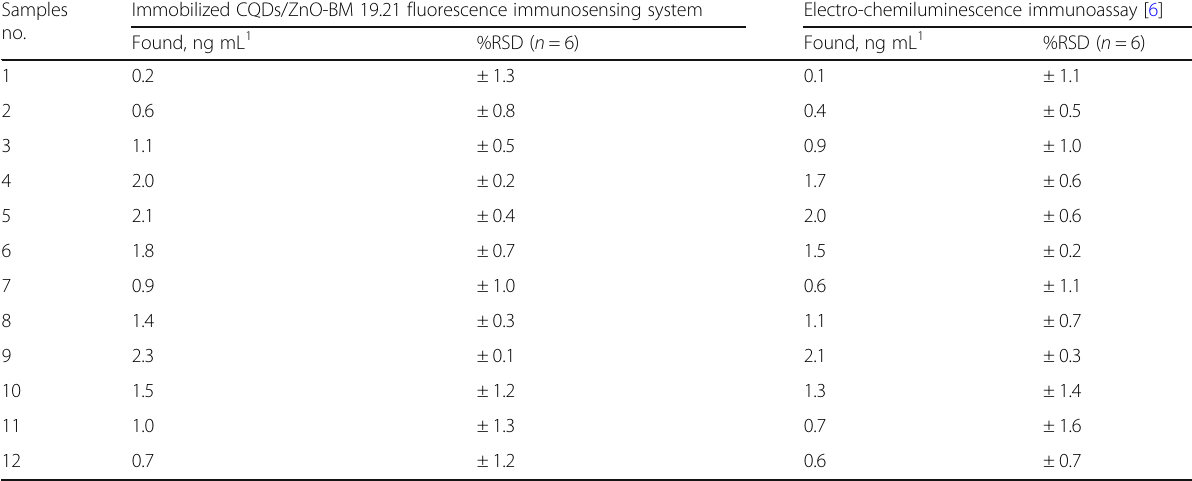
Table 2 Comparative study using immobilized CQDs/ZnO-BM 19.21 fluorescence immunosensing system and electro- chemiluminescence immunoassay [6] Samples